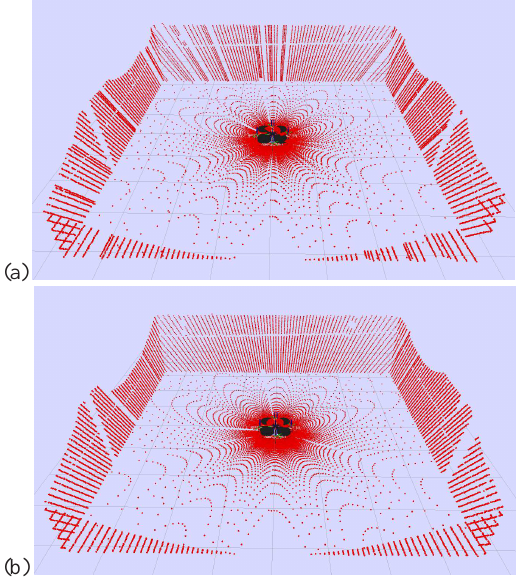
Figure 4: 3D laser scan from a simulated environment. (a) The effects resulting from varying communication latencies. (b) After filtering the encoder position assuming constant rotational veloc- ity.